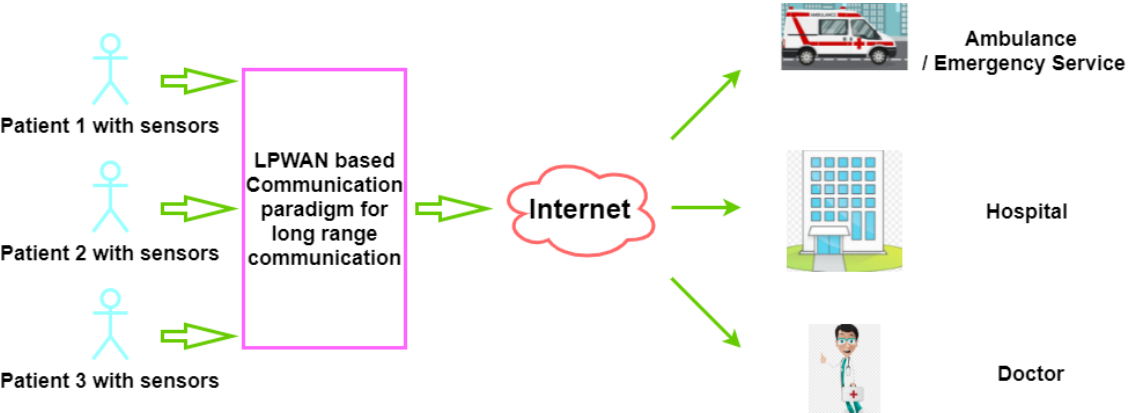
Figure 2. A conceptual LPWAN-based e-health